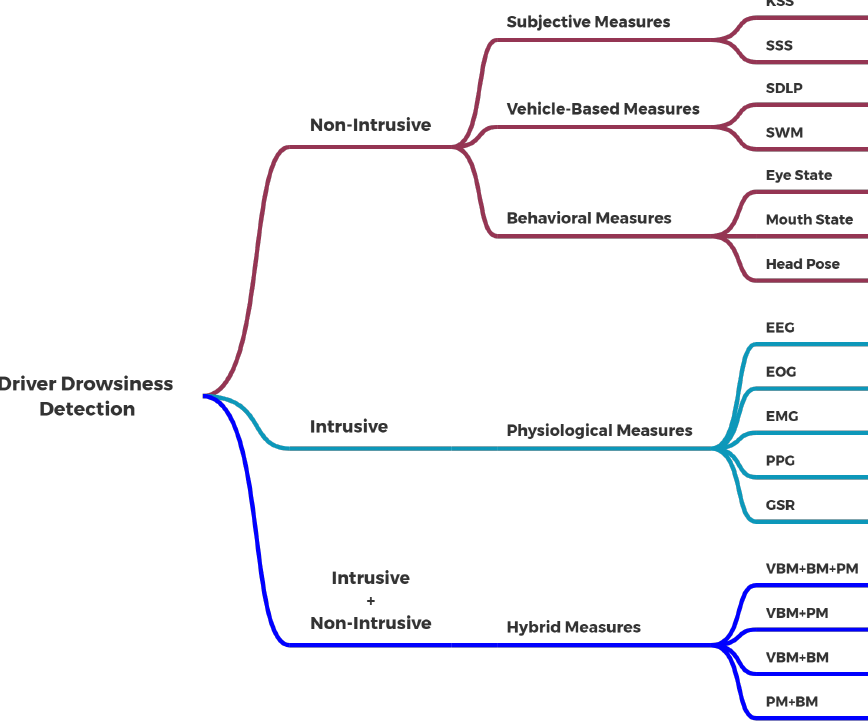
Figure 1. Driver drowsiness detection measures and respective techniques